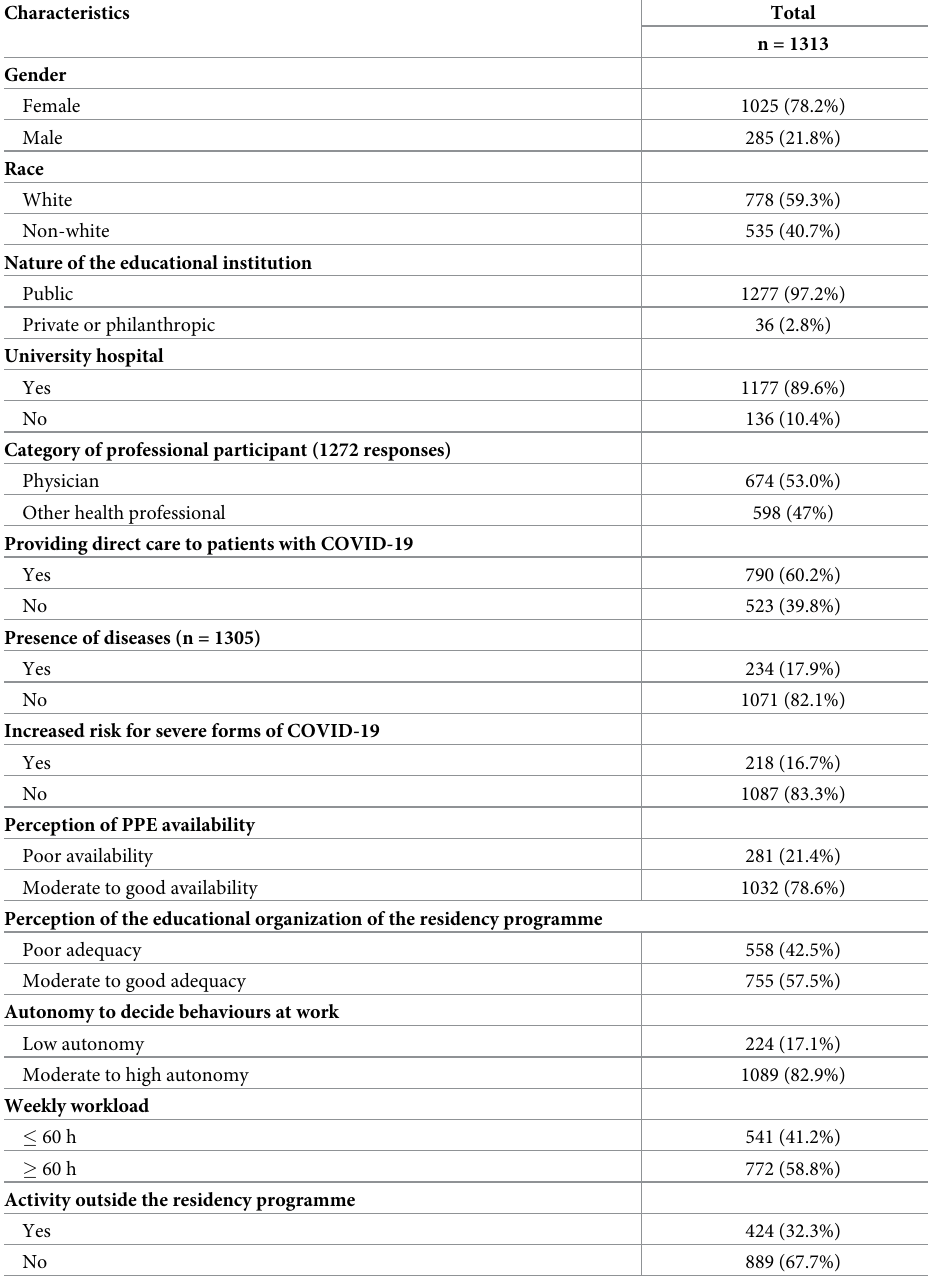
Table 1. General characteristics of the study